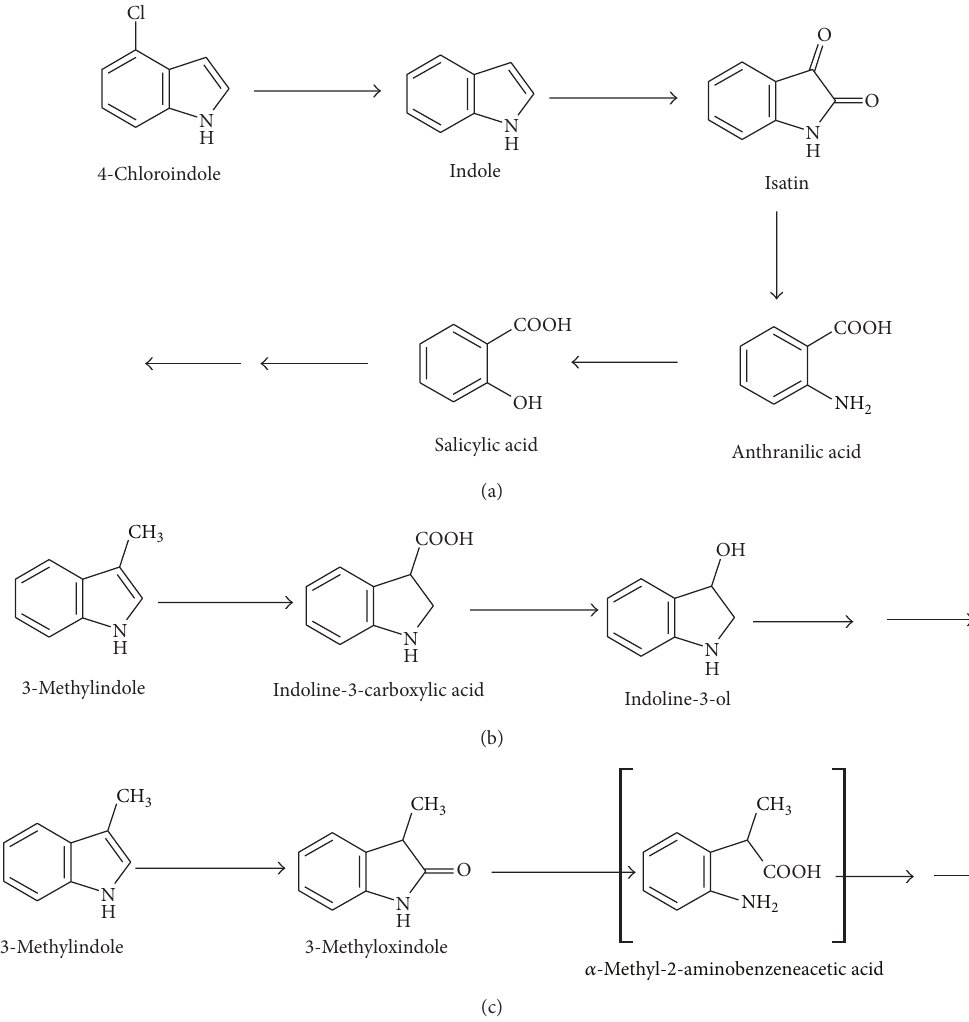
Figure 7: Degradation pathway of (a) 4-chloroindole in Exiguobacterium sp. PMA [28], (b) 3-methylindole in Pseudomonas sp. GS [44], and (c) 3-methylindole by a sulfate reducing consortium